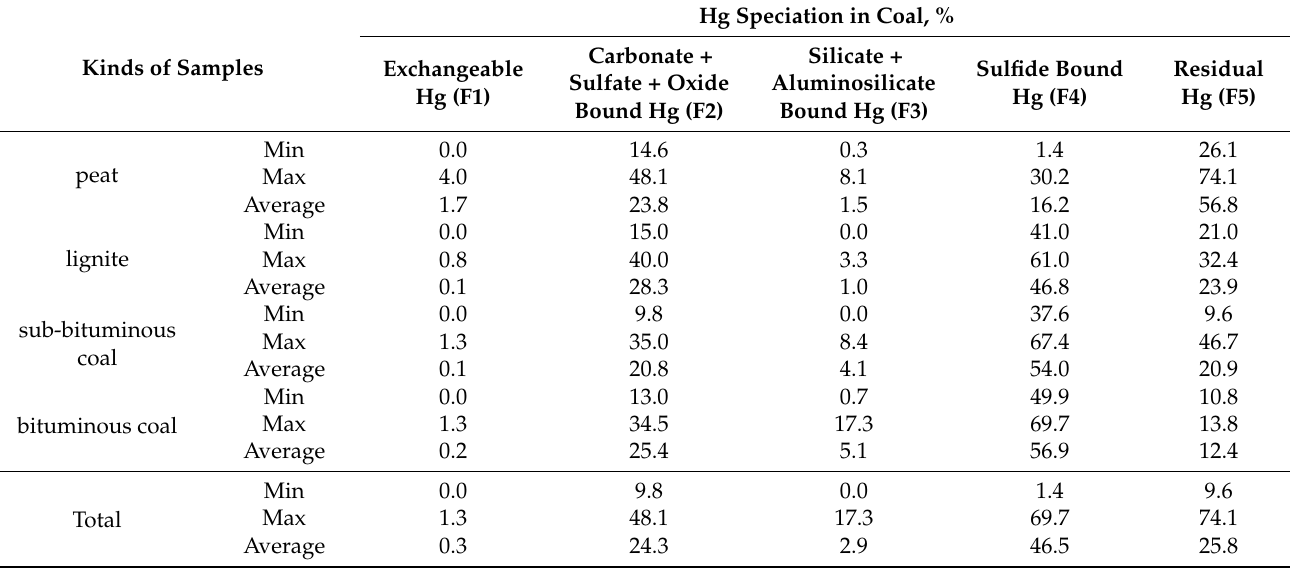
Table 8. Hg speciation in 59 coal samples with different ranks.